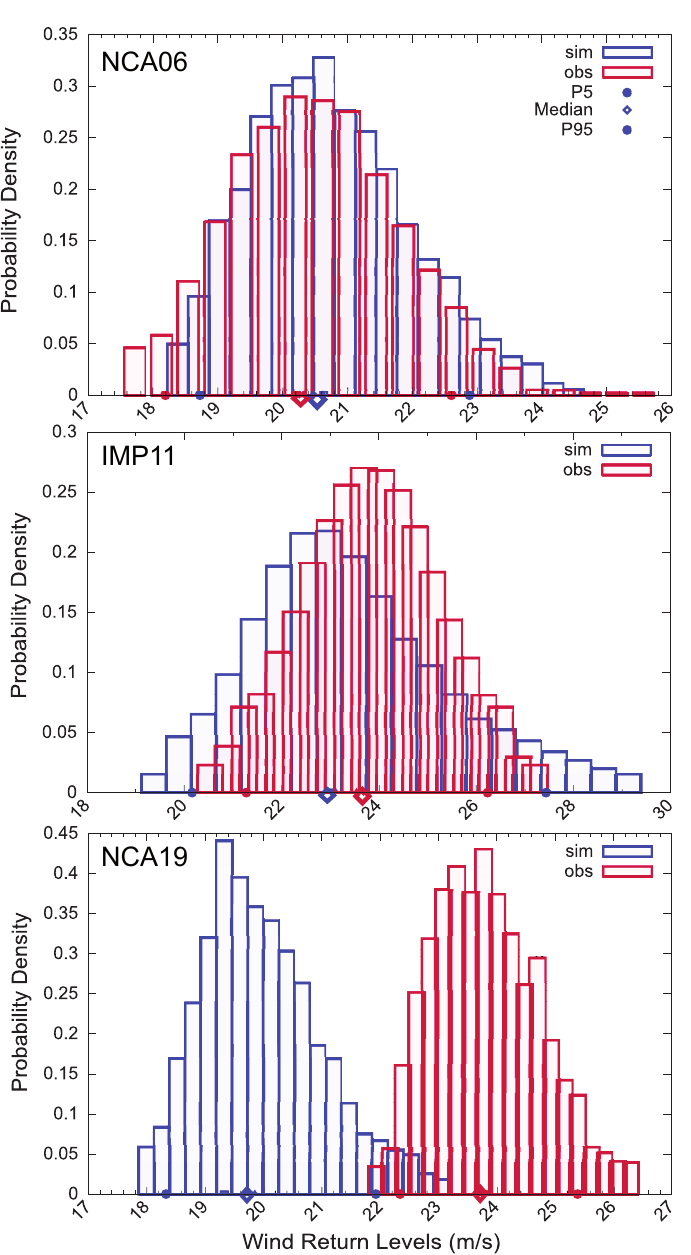
Figure 11. PDF of wind return values for a 50-year return period obtained from observations in red and simulated wind in blue at the NCA06 ( top ), IMP11 ( middle ) and NCA19 ( bottom ) sites. The 5th and 95th percentiles (circles), and the median (diamonds) are also